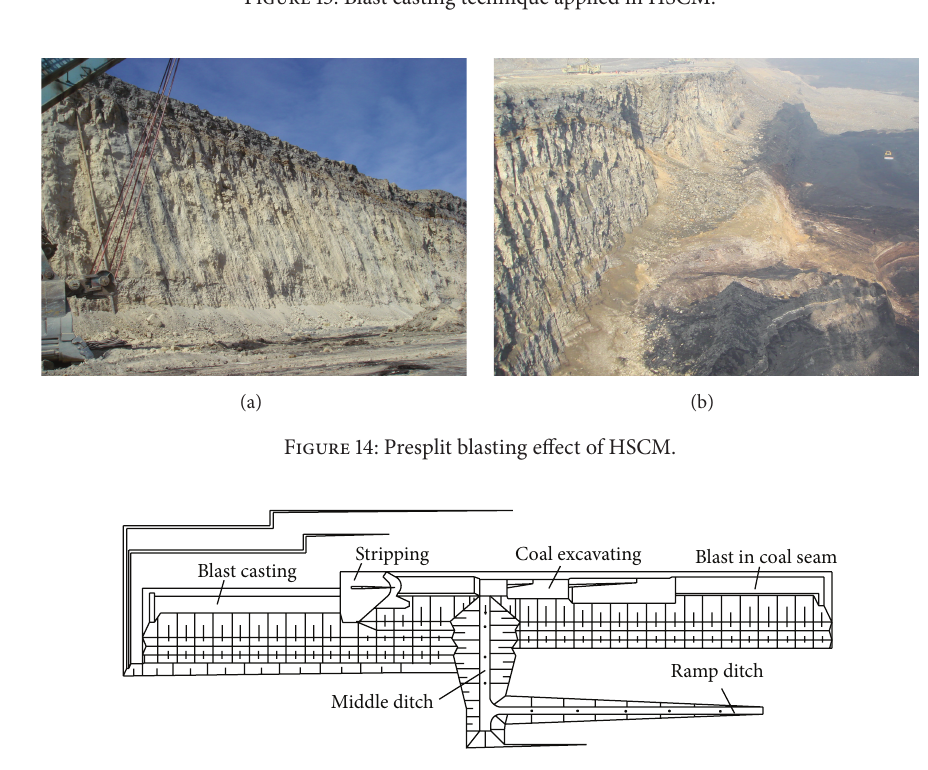
Figure 15: Operating process and coal excavating of dragline stripping. Table 3: Blasting vibration velocity of monitoring